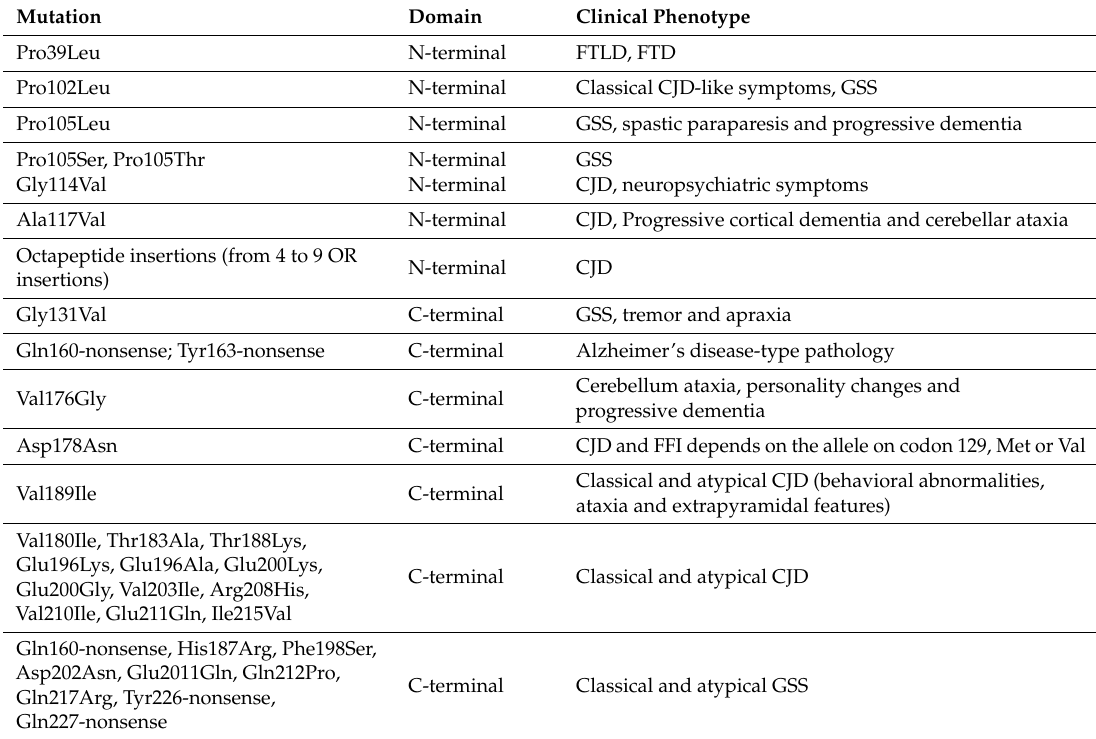
Table 1. PRNP mutations and associated phenotypes